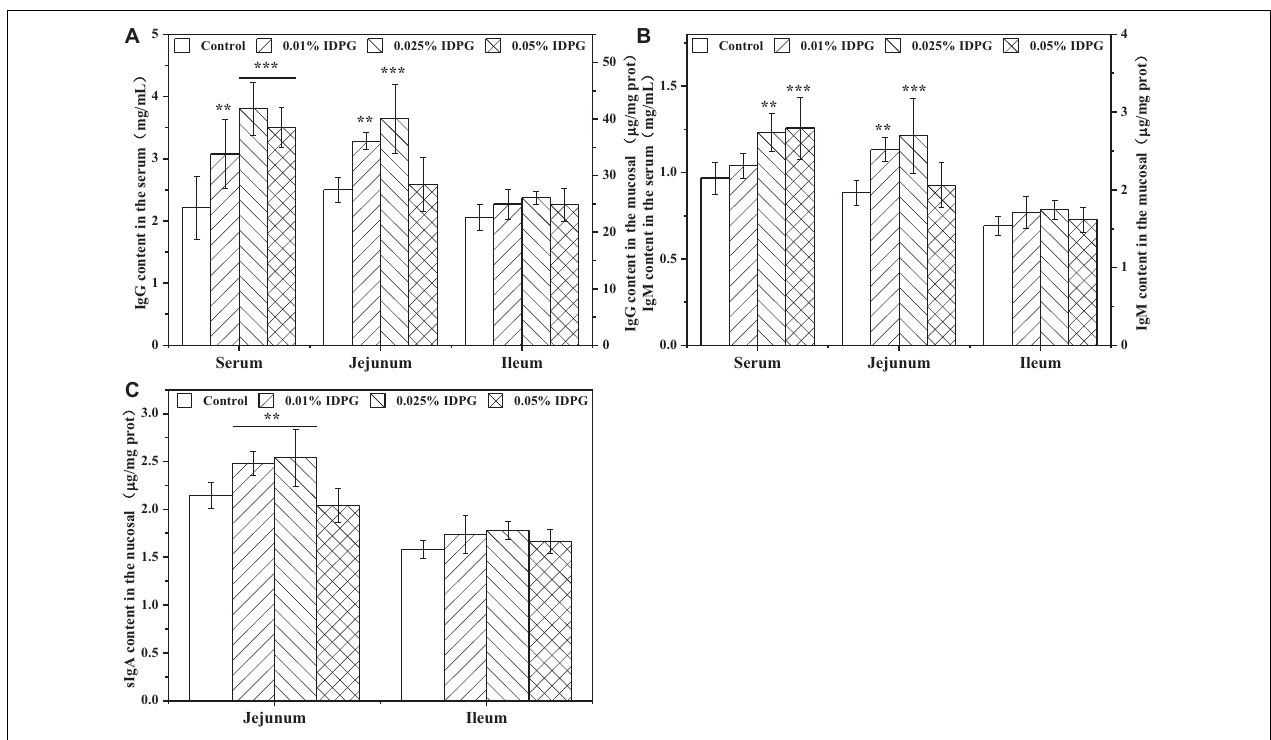
FIGURE 5 | Immunoglobulins in the serum, jejunum and ileum of laying hens fed diets supplemented with incomplete degradation products of galactomannan (IDPG). ** P < 0.01 and *** P < 0.001 compared with control group in each tissue. (A) Immunoglobulin G (IgG); (B) IgM; (C) secretory IgA (sIgA).